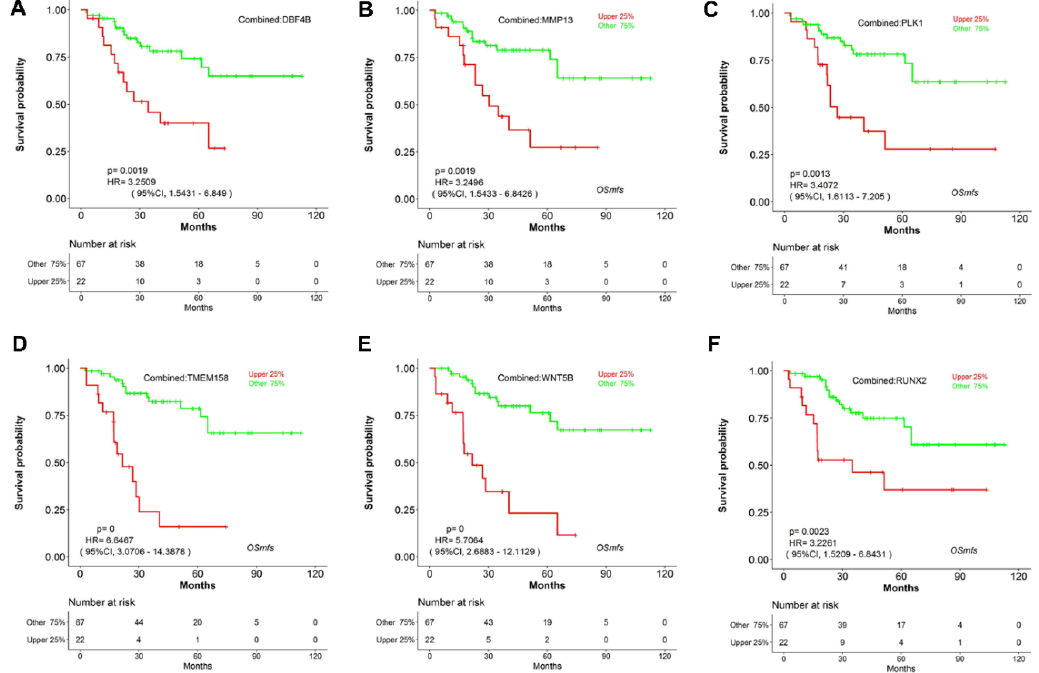
Figure 4. The combined overall survival analysis of DBF4B ( A ), MMP13 ( B ), PLK1 ( C ), TMEM158 ( D ), WNT5B ( E ), RUNX2 ( F ) according to TCGA, GSE71118, GSE72545 cohorts in OSmfs.